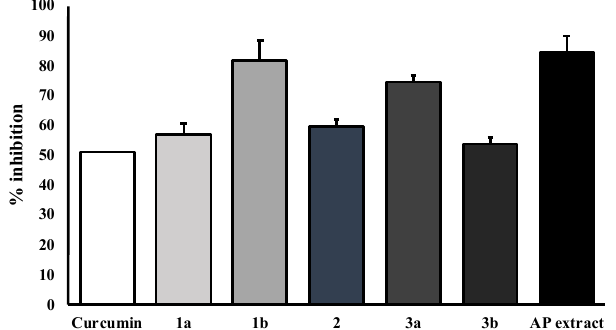
Figure 9. Effects of the AP extract and its flavone constituents on A β aggregation at equivalent amounts by ThT assay. The values are presented as mean ± SD (n = 3).